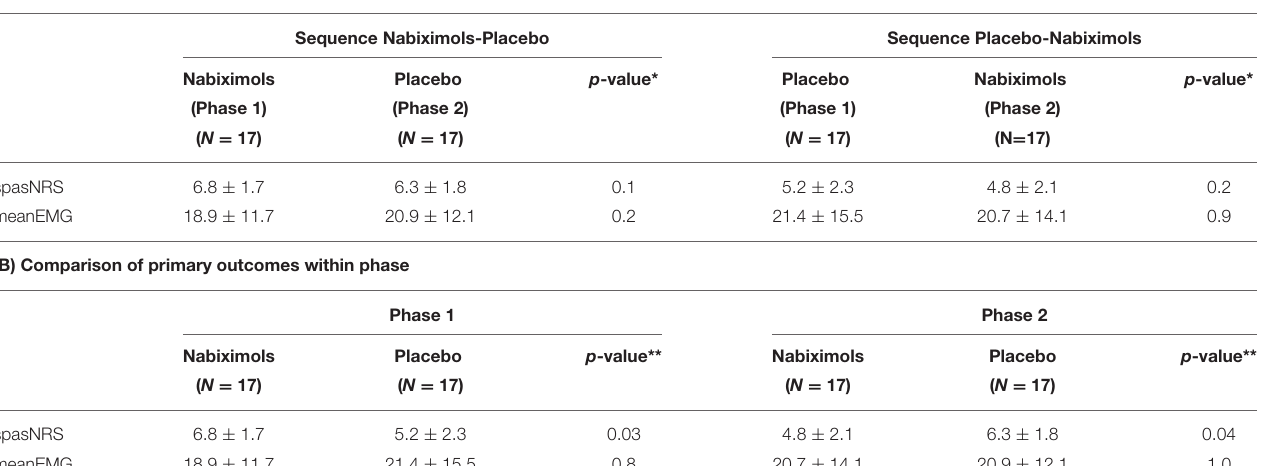
TABLE 4 | Risk of bias assessment. (A) Comparison of primary outcomes within